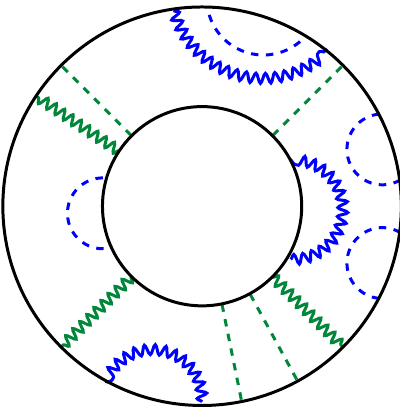
Figure 1 . Ladder (green) and rainbow (blue)